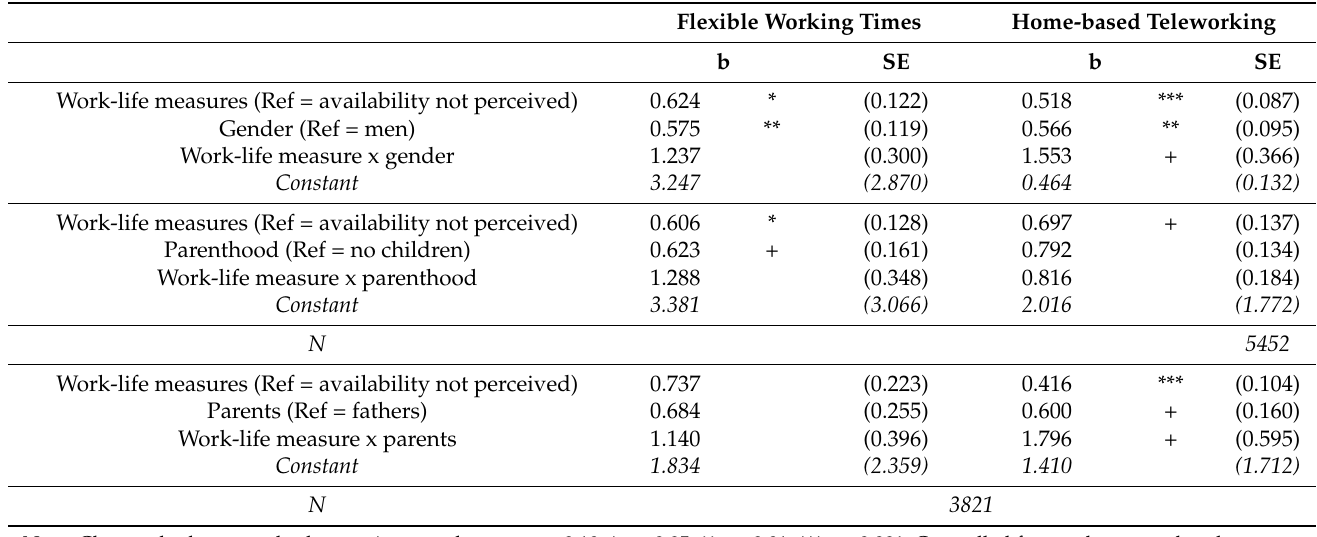
Table 4. Group differences in the association between voluntary employee exit and work-life measures (logistic regression with organizational mixed effects and clustered standard errors).